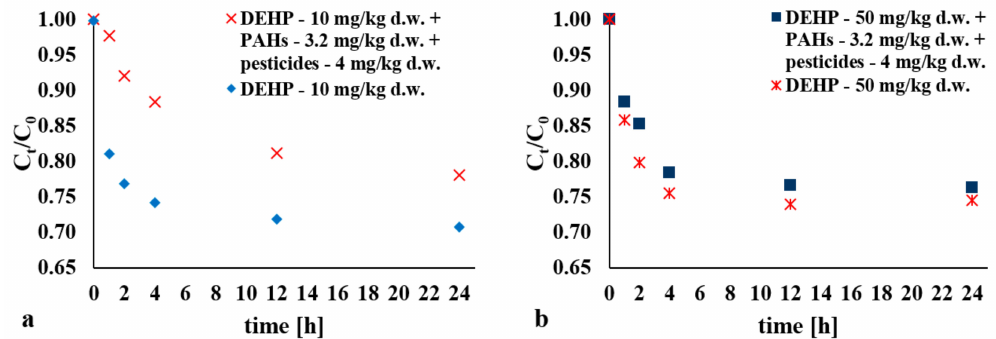
Figure 6. Impact of other hard-to-degrade impurities in the H 2 O 2 / Fe 3 + process (H 2 O 2 :Fe 3 + 1:1, pH = 3) on the DEHP distribution for: ( a ) C 0 = 10 mg / kg d.w.; ( b ) C 0 = 50 mg / kg d.w. PAH: polycyclic aromatic